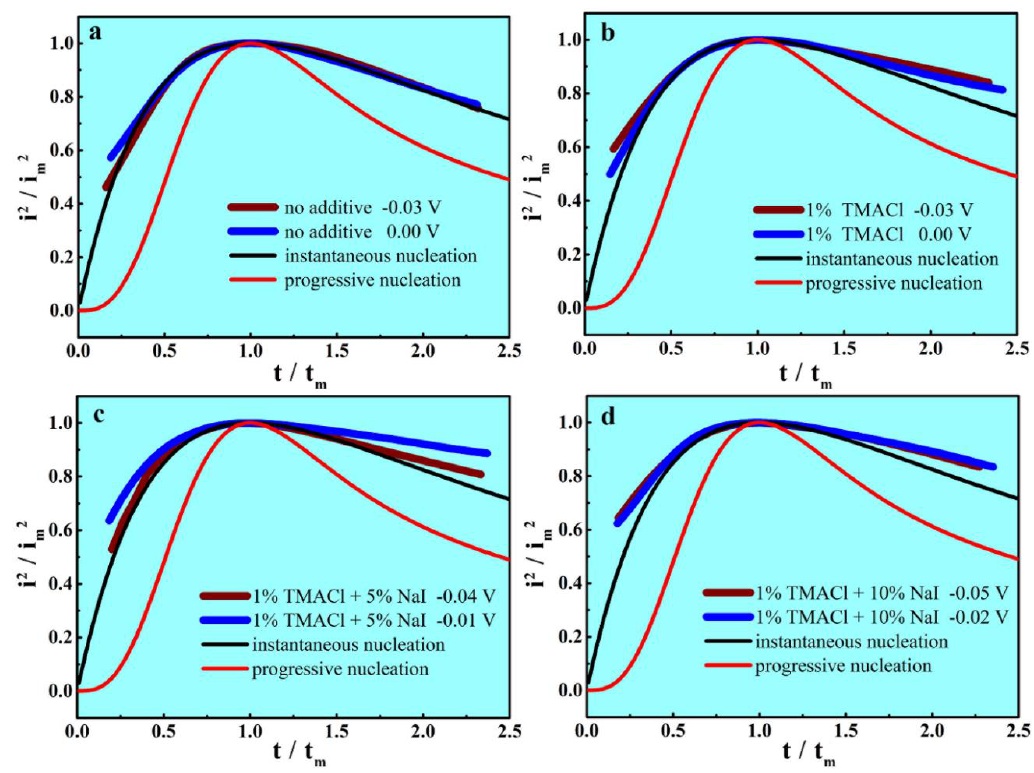
Figure 4. The comparison of the experimental and theoretical plots of (i / i m ) 2 vs (t / t m ) in the AlCl 3 -NaCl-KCl molten salts electrolyte, ( a ) no additives, ( b ) 1% TMACl, ( c ) 1% TMACl + 5% NaI and ( d ) 1% TMACl + 10%